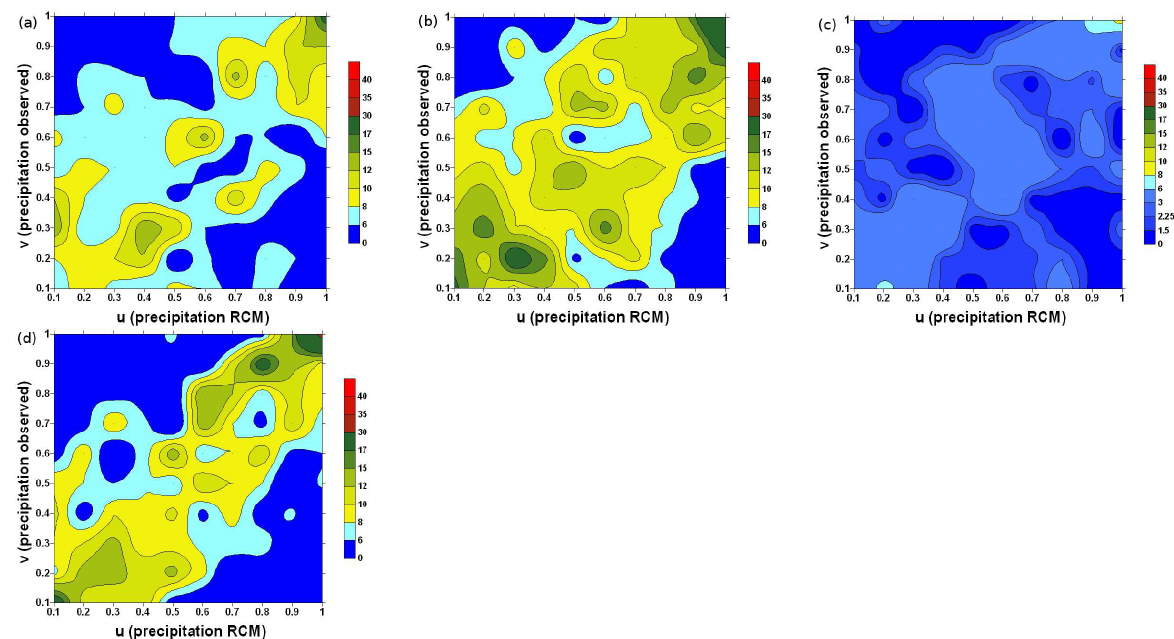
Fig. 10. Empirical Copula density for modelled ( u ) and observed precipitation (v) for Garmisch-Partenkirchen, using the weather type classification following the cyclonality in 950 hPa and 500 hPa respectively: (a) AA, (b) AC, (c) CA, and (d) CC (A – anticyclonic, C – cyclonic).